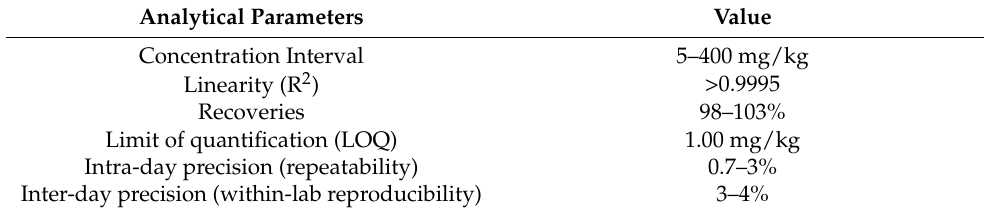
Table 3. LC-MS/MS validation